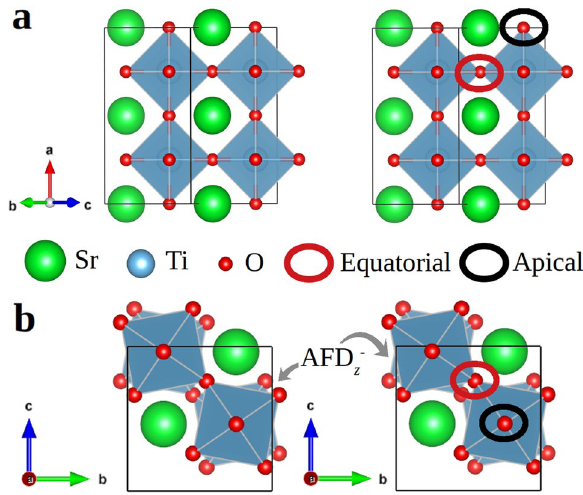
Figure 1. Representation of the 20-atoms simulation cell employed for the simulation of stoichiometric and epitaixally strained (001) SrTiO 3 thin films. Different views of the simulation cell are represented in ( a ) and ( b ) along with the typical antiphase out-of-plane oxygen octahedral antiferrodistortive distortions ( AFD − z ) found in (001) SrTiO 3 thin films. The generic positions of equatorial and apical oxygen ions are indicated in the figure and the Ti atoms are located inside the shaded O 6